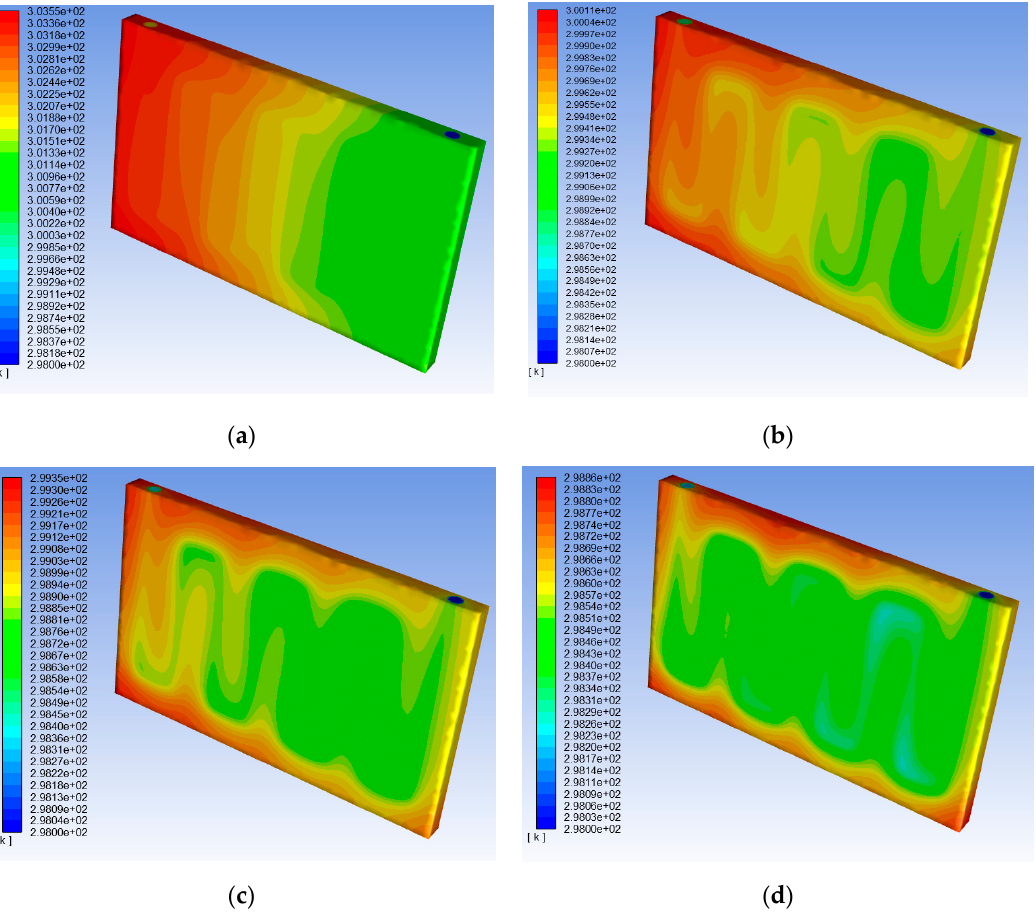
Figure 8. Temperature distribution for different entrance velocities: ( a ) 0.1 m/s, ( b ) 0.5 m/s, ( c ) 1 m/s, ( d ) 2 m/s. Table 1. A comparison of di ff erent